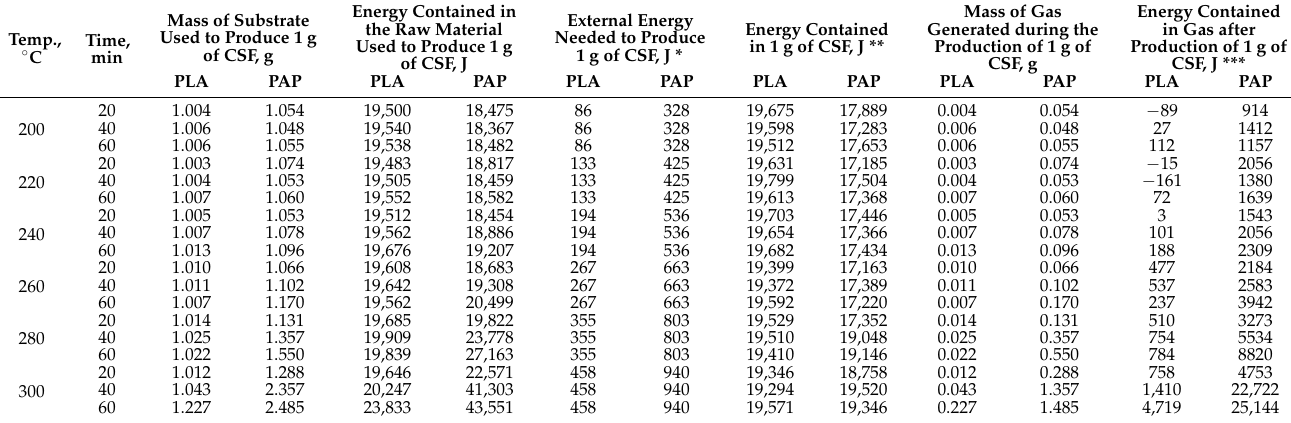
Table 3. Torrefaction mass and energy balance for production of 1 g of CSF from PLA and Paper wastes. Temp., ◦